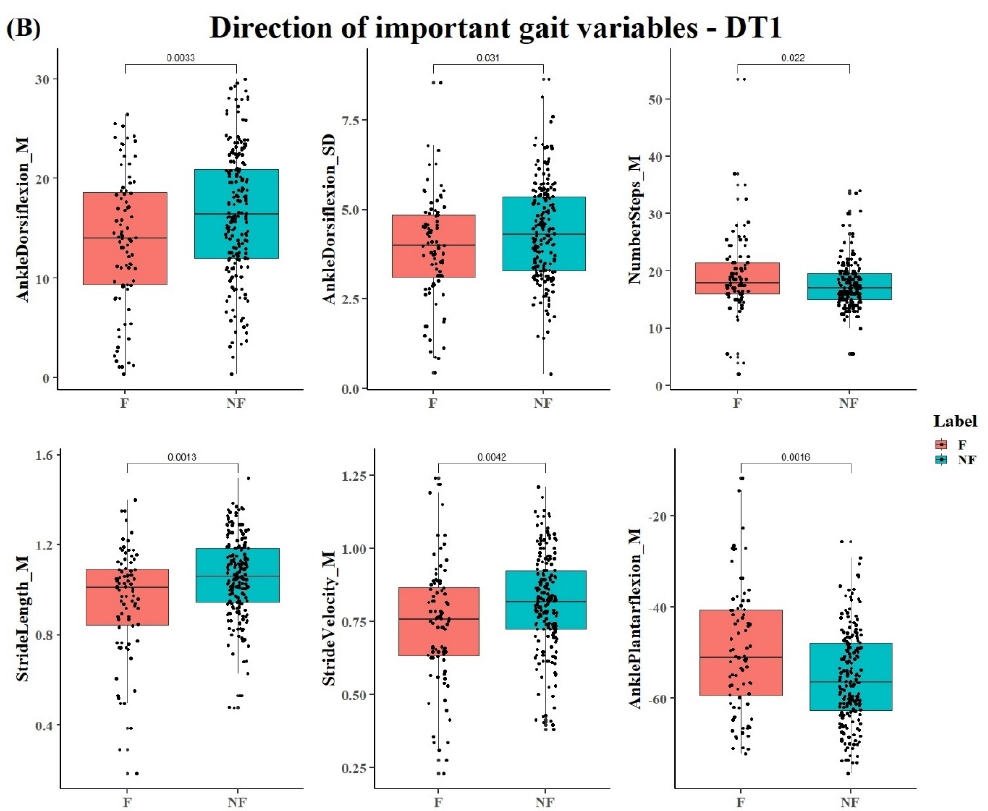
Figure 3. ( A , B ) show the direction of variables that contribute more to the PLS-DA model in and DT1. The x-axis represents the groups of fallers and non-fallers, and the y-axis shows the coefficients of each variable in each square. The vertical bars indicate the confidence interval. Dots show the individual data of the participants. DT1 = walking and checking boxes on a paper sheet. Note that the results for DT2 were similar as for DT1.